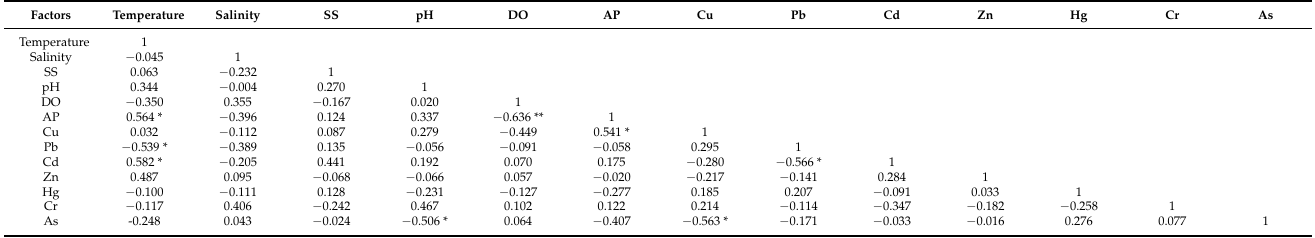
Table 3. Correlation analysis between factors in surface water.